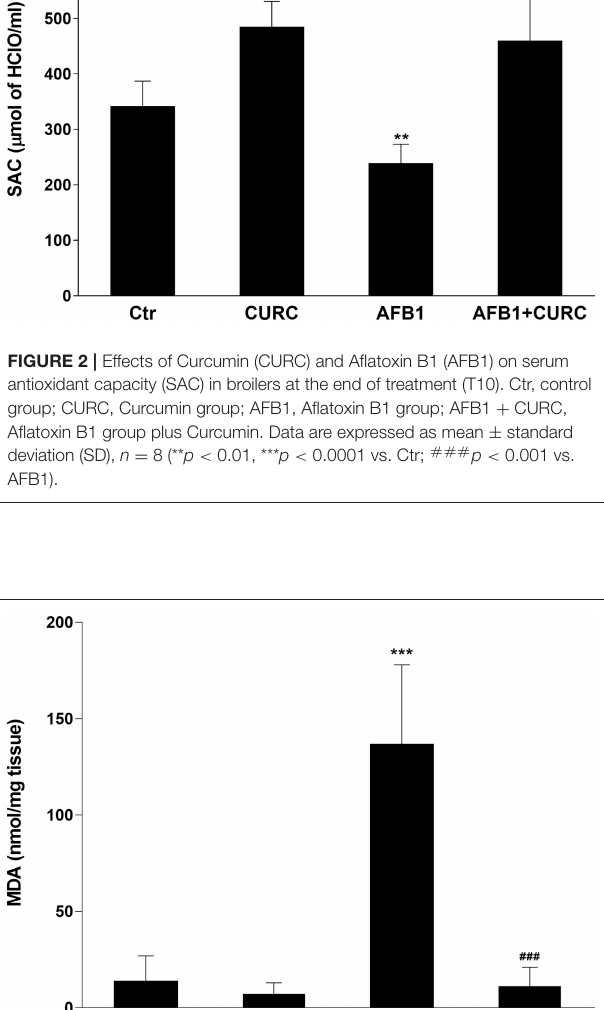
significantly increased by ∼ 10-fold in broilers treated with AFB1 alone compared with the control group ( ∗∗∗ p < 0.0001 AFB1 vs. Ctr). CURC alone did not affect the kidney MDA levels, but significantly decreased to basal values the altered levels triggered by the AFB1 treatment ( ### p < 0.0001 AFB1 vs. AFB1 + CURC) ( Figure 3